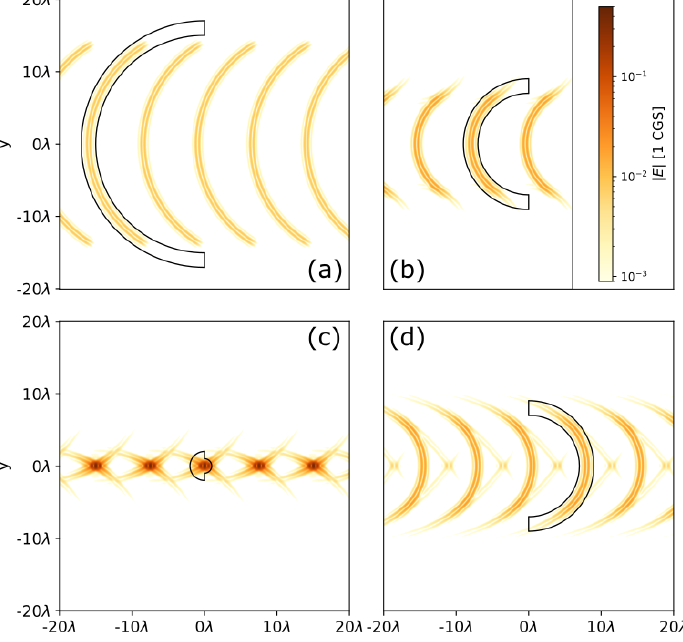
Figure 2. Illustration of the idea of the proposed method. The pictures show the evolution of the electromagnetic field composed by the equidistant replication of the initial pulse along the x axis: the field intensity is shown for ( a ) t = − R 0 / c , ( b ) t = − R 0 /2 c , ( c ) t = 0 and ( d ) t = R 0 /2 c with f − number = 0.3 ( θ ≈ 1 rad), λ = 1 µ m, R 0 = 16 λ , L = 2 λ , ε = 0.1 rad, P 0 = 1